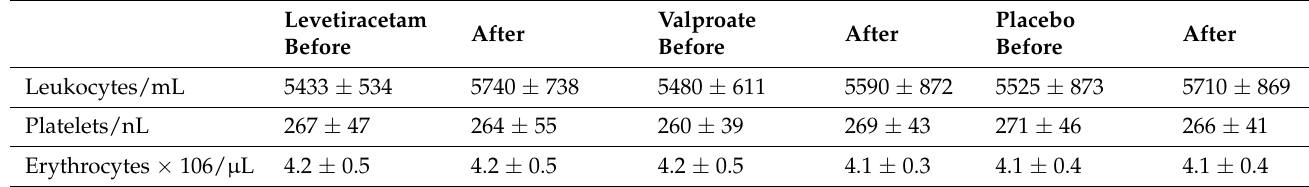
Table 1. Difference between cell counts before and 90 min after intake of study drugs presented as arithmetic mean and standard deviation. No significant differences as analysed by Wilcoxon